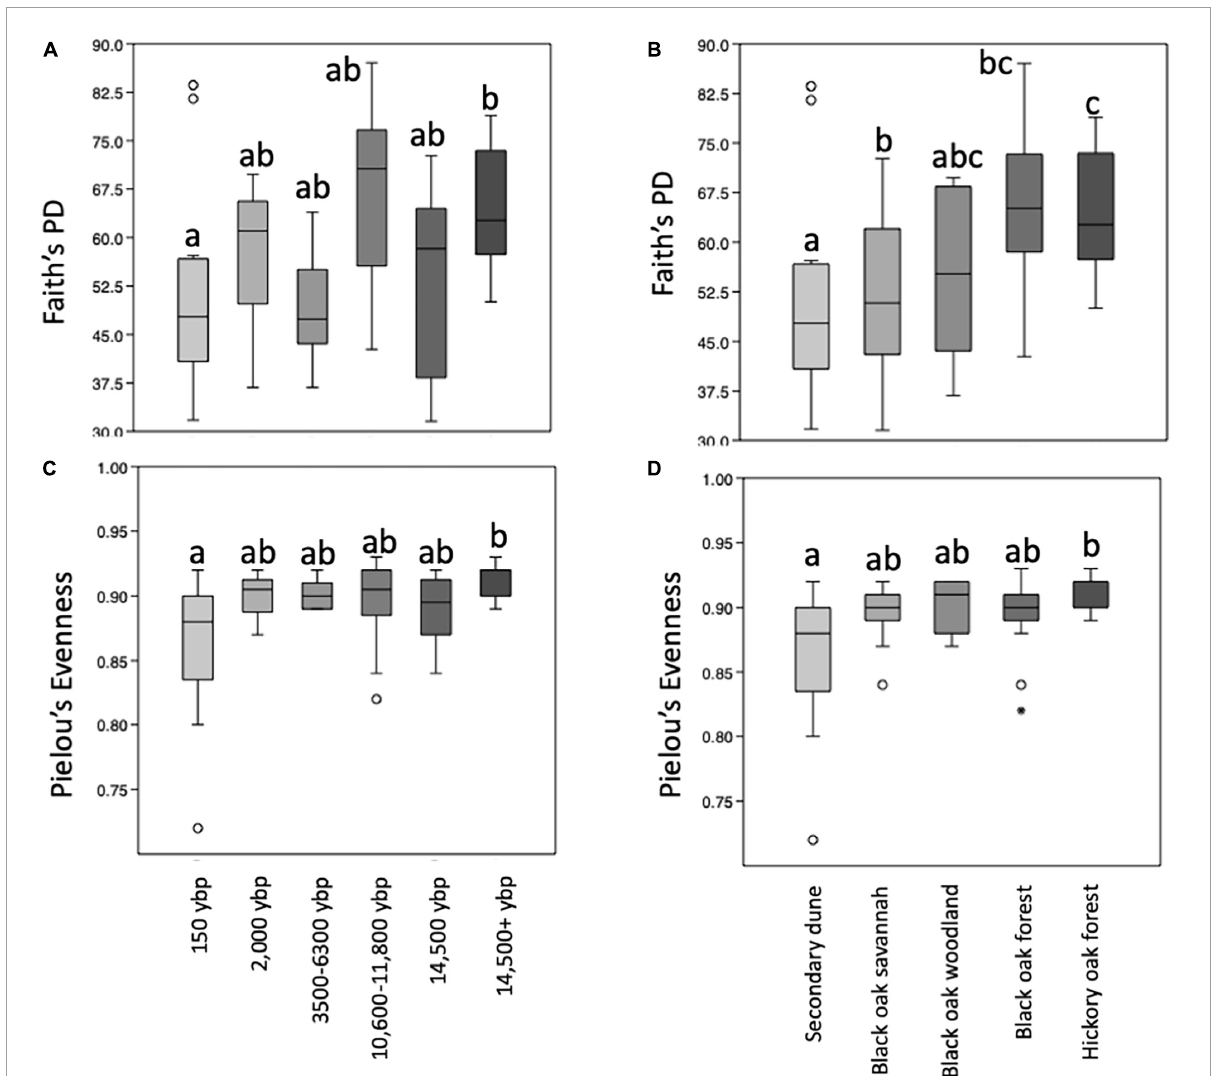
FIGURE3 Boxplots representing the medians and upper and lower quartile values of within sample (alpha) diversity metrics (A,B) PD whole tree (Faith’s phylogenetic diversity (PD), richness) and (C,D) Pielou’s evenness of samples from different soil geologic ages (A,B) and habitats (C,D) . Kruskal Wallis indicates overall differences for all metrics tested are significant ( p < 0.02) and pairwise-tests with 999 permutations with significant differences at q < 0.05 illustrated by different letters above bars. Outliers are represented by open circles. Samples were collected at Indiana Dunes National Park in